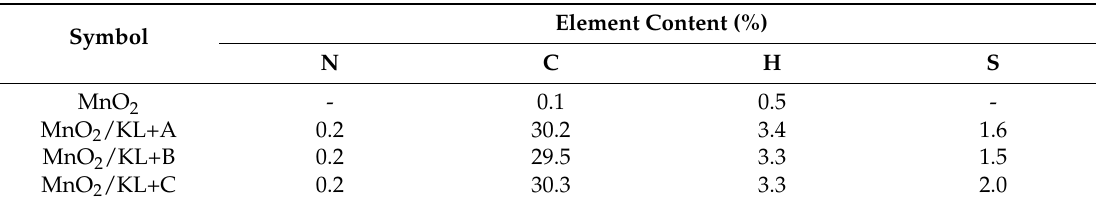
Table 4. Elemental contents of manganese oxide and MnO 2 /lignin hybrid materials based on activated biopolymer in selected ionic liquids.